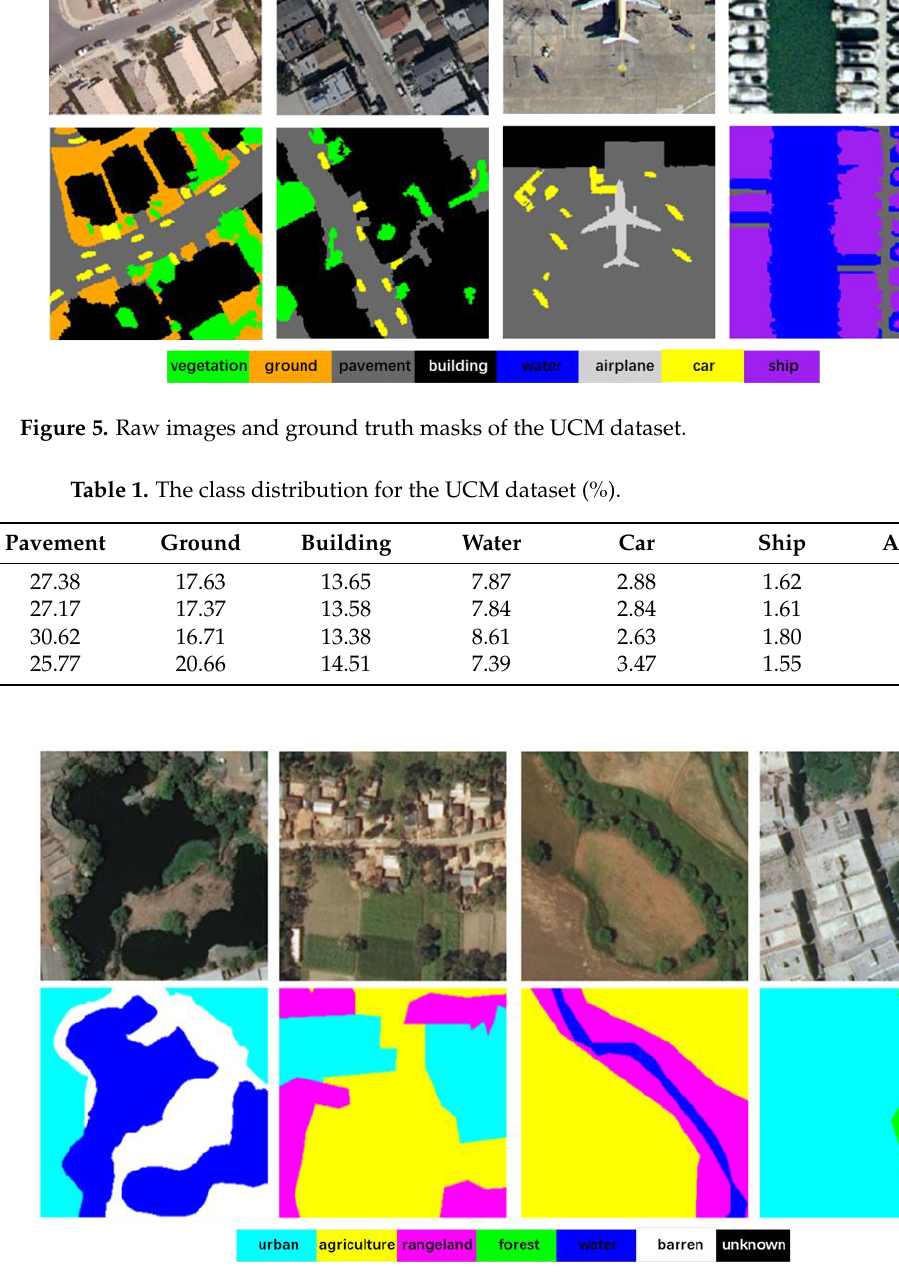
Figure 6. Raw images and ground truth masks of the DeepGlobe dataset.